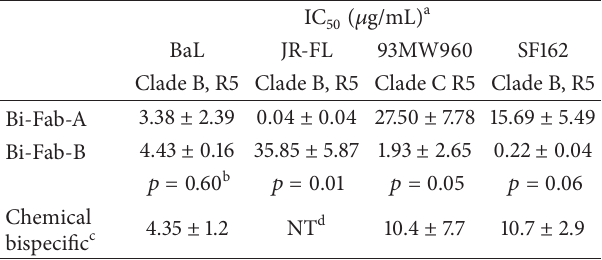
Table 1: ADCVI activity of HIV-1 by F240 Bi-Fab antibody con-